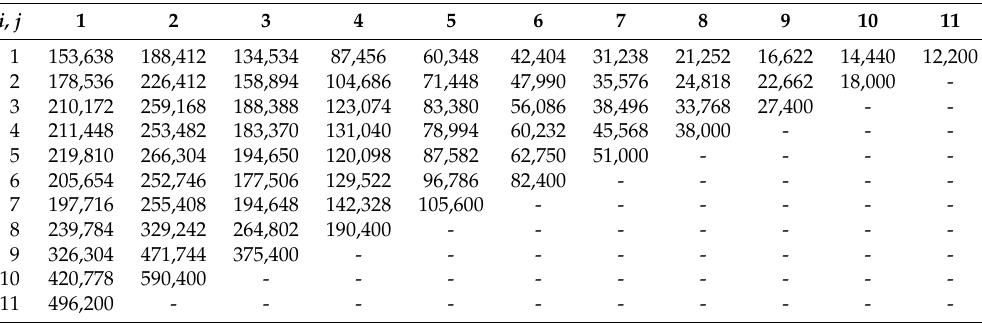
Table A2. Insurance run-off triangle taken from Barnett and Zehnwirth (2000, Table 3.5) as used in the empirical application in Section 5.1 and the simulations in Section